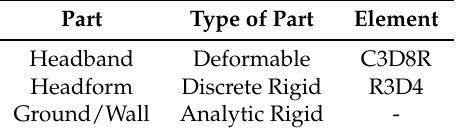
Table 8. Details of the numerical model headform-headband system for impact test